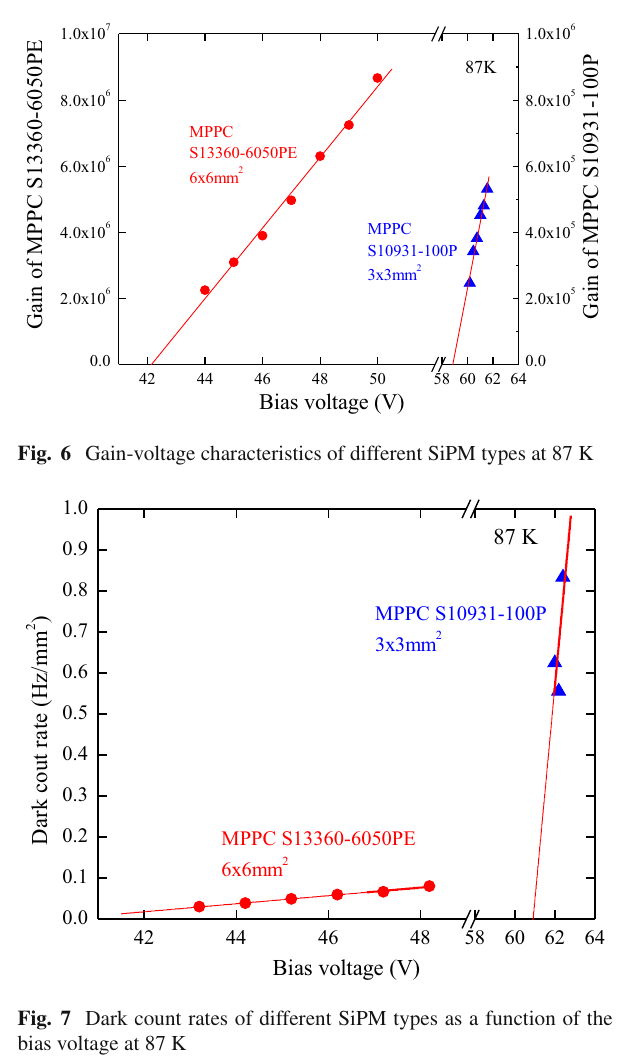
Fig. 7 Dark count rates of different SiPM types as a function of the bias voltage at 87 K